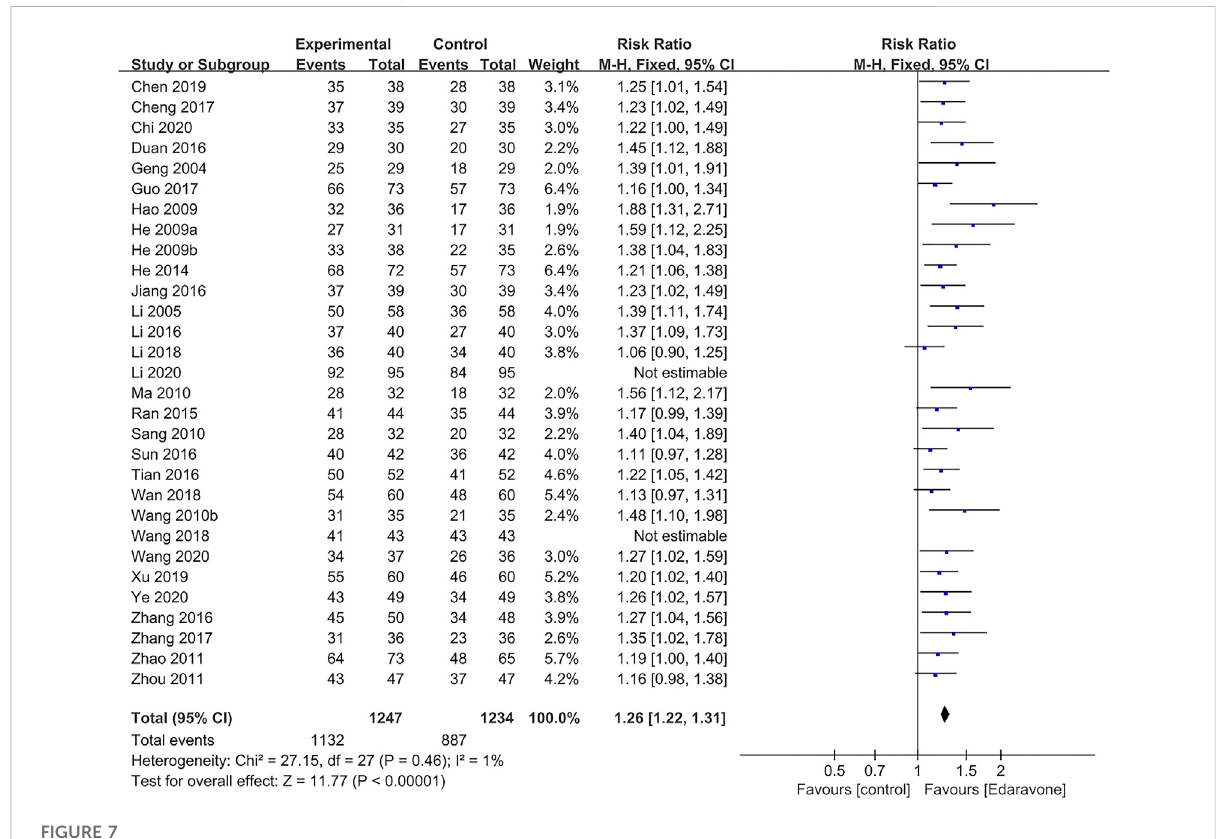
FIGURE 7 Forest plot for the effect of edaravone on the total ef fi ciency rate.